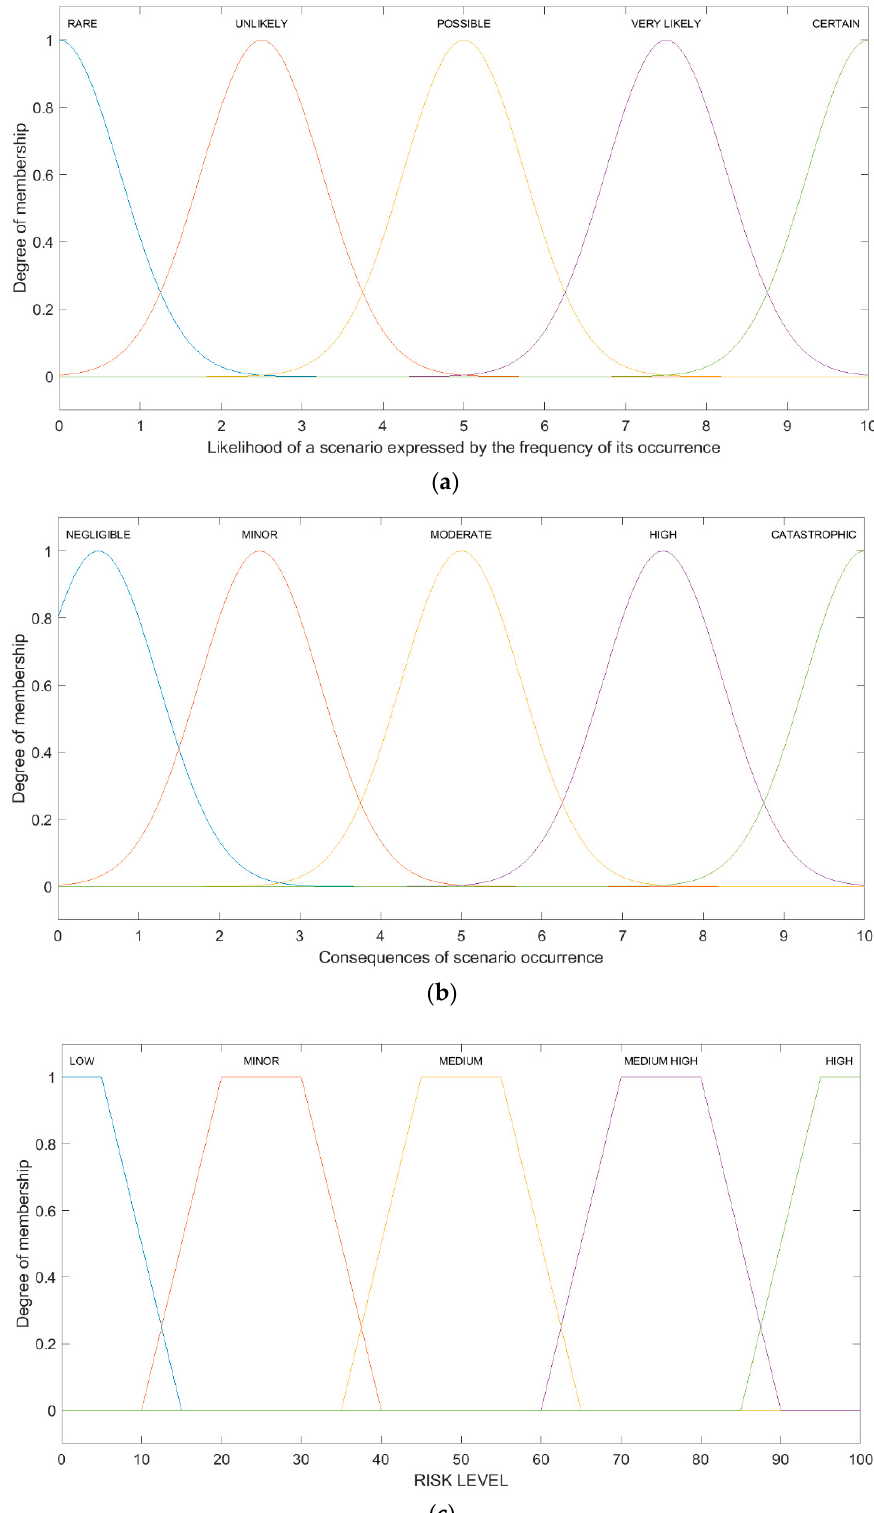
Figure 6. The shape of membership functions: ( a ) Likelihood of the scenario expressed by the frequency of its occurrence; ( b ) Consequences of the scenario occurrence; ( c ) Risk level.